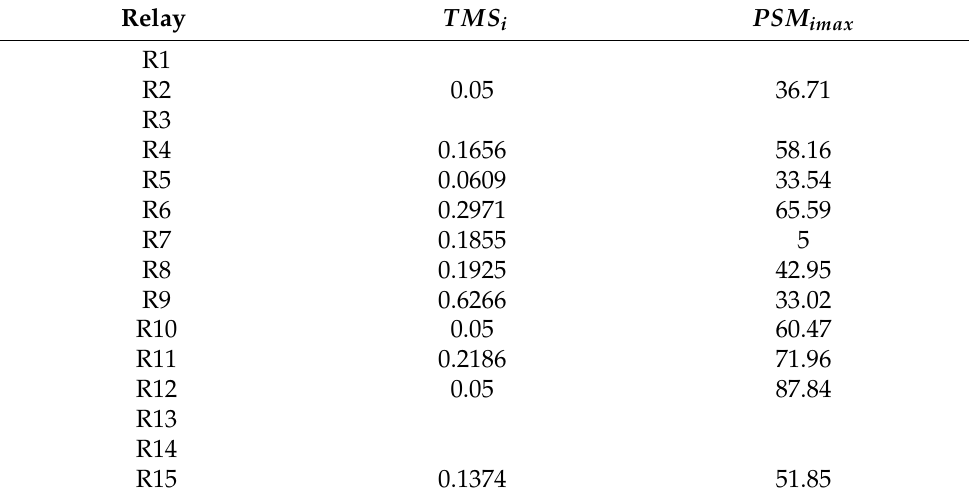
Table 7. Coordination parameters for Scenario 3.